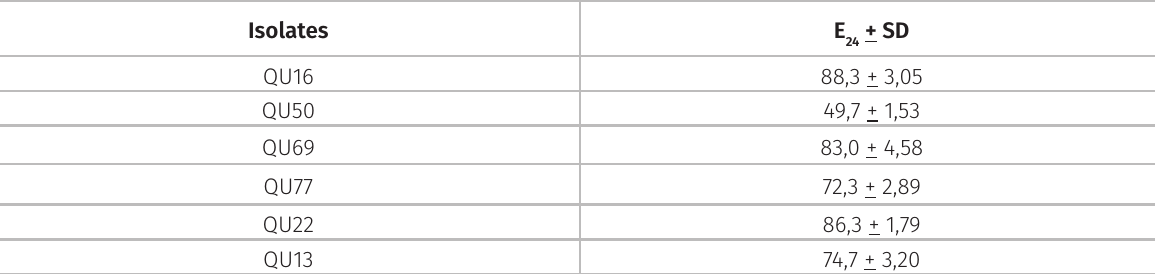
Table III. Emulsification indexes values in percentage of Y. lipolytica isolates